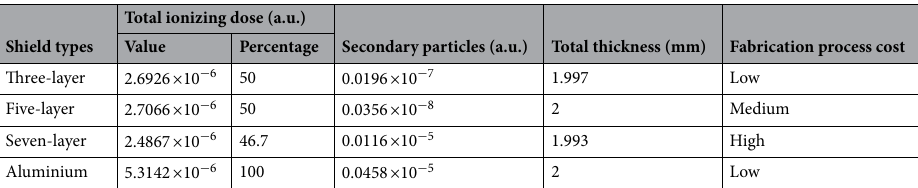
Total ionizing dose (a.u.) Shield types